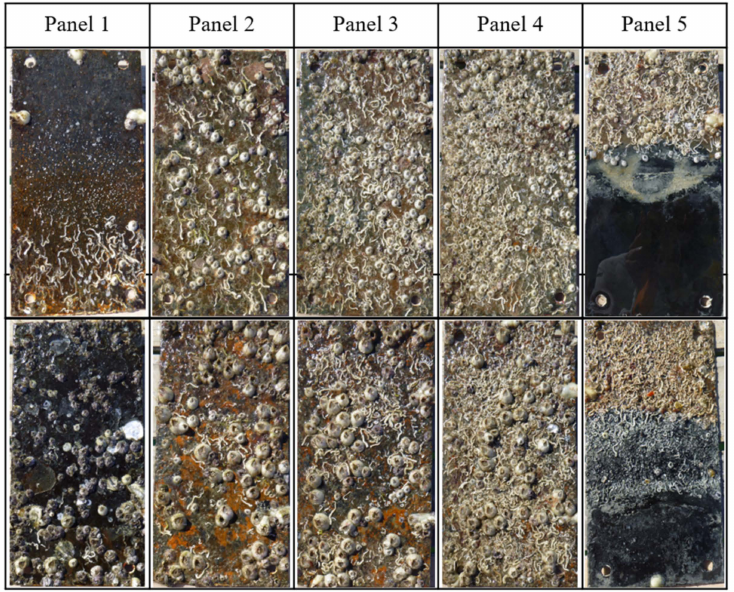
Figure 9. Final visual assessment of the initially clean ( top ) and the previously fouled and corroded ( bottom ) panels after light cleaning.